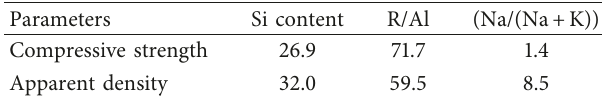
Figure 1: Effect of the studied parameters on the development of the compressive strength and apparent density. Table 4: Contribution (%) of the studied parameters on the de- velopment of the compressive strength and apparent density.